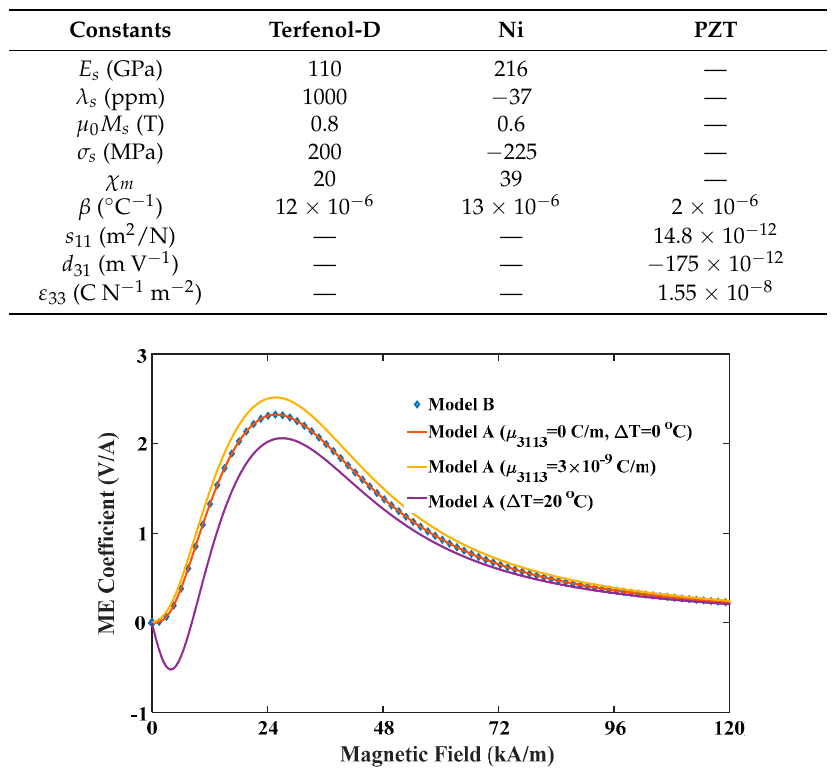
Table 1. Material constants of FE and FM materials.